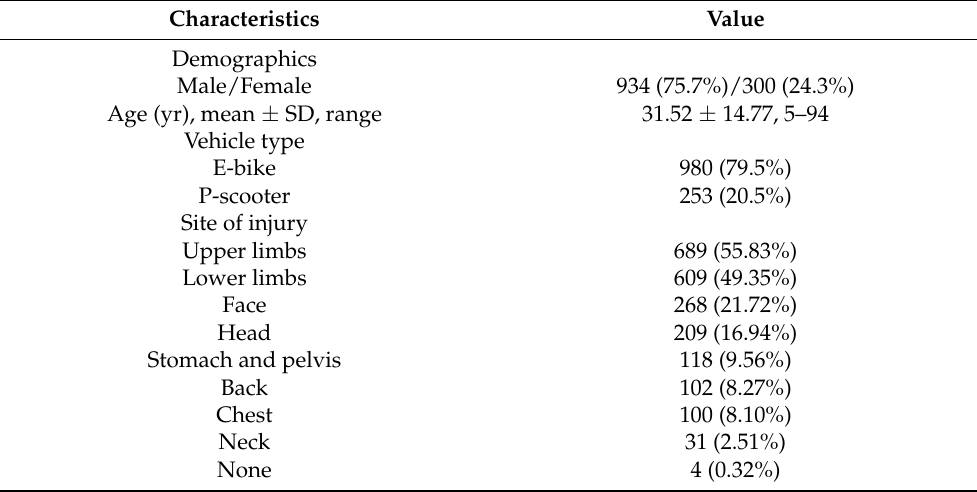
Table 1. Demographic and clinical characteristics of the cohort (N = 1234).